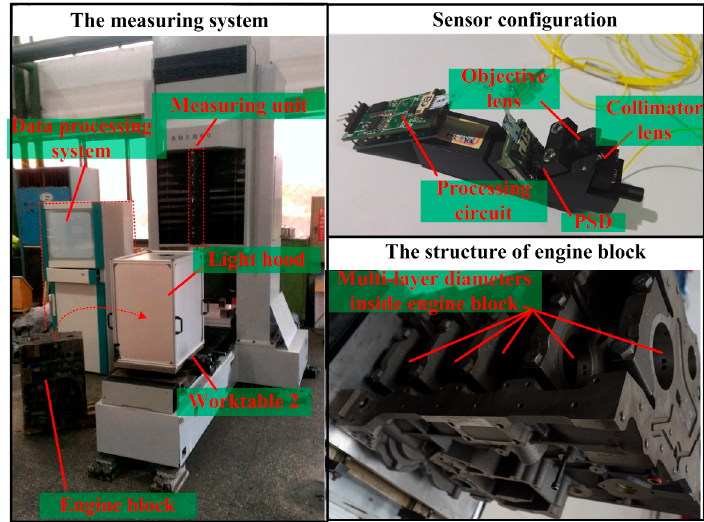
Figure 9. The measuring system on site. Table 2. Measuring data of Engine Block 1# (mm).